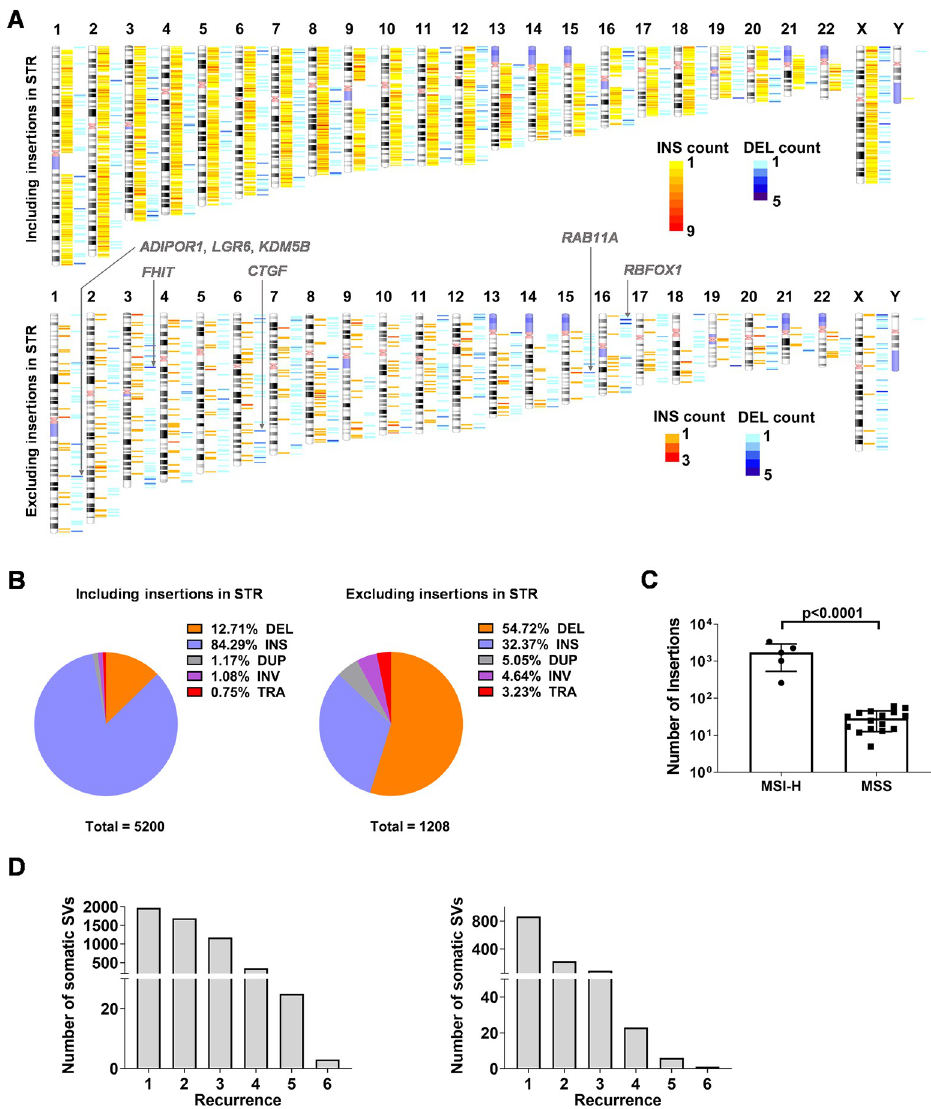
Fig 2. Detection of somatic SVs in CRC by long-read sequencing. (A) Chromosome ideogram showing somatic deletions (DEL) and insertions (INS) identified by long-read sequencing in 21 pairs of CRC samples. (B) Pie chart showing the percentages of different classes of SVs identified from long-read sequencing data including or excluding insertions in STR regions. (C) Quantification of somatic insertions in MSI-H or MSS samples (p < 0.0001, Student’s t - test). (D) The quantities of somatic SVs that were detected in multiple samples, including (left) or excluding insertions in STR regions (right). The “Recurrence” on X-axis refers to the number of samples in which an SV is